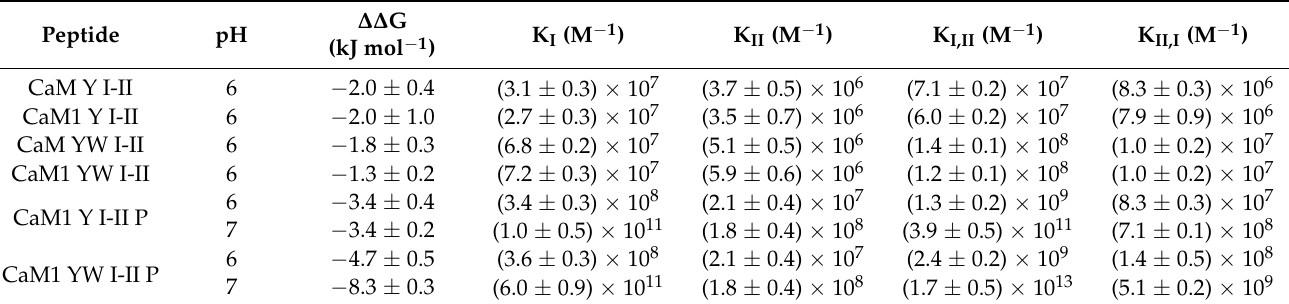
Table 4. Cooperativity parameters and microscopic binding constants for reaction of UO 22+ ion with the two-site mutants of CaM N-terminal domain, evaluated using spectrofluorimetric experimental data. I = 0.12 M (MES, KCl); T = 298